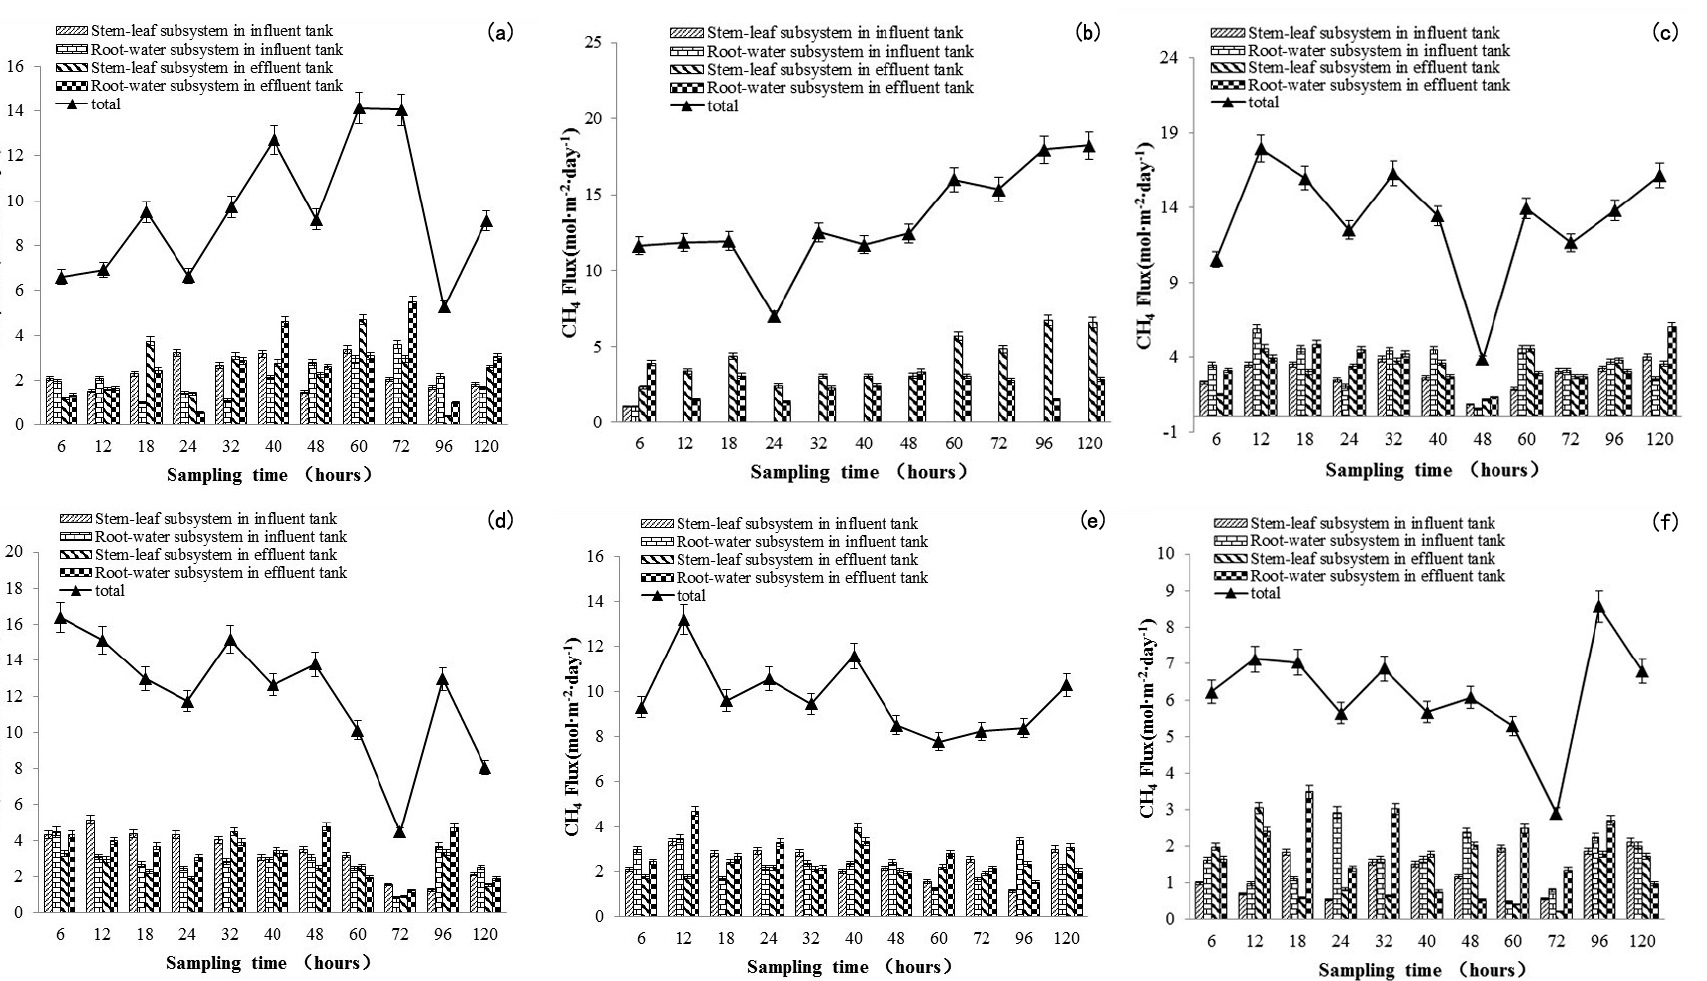
Figure 2. The methane emissions fluxes from the IVCW. ( a ) 0 mmol / L ethanol added; ( b ) 2 mmol / L ethanol added; ( c ) 4 mmol / L ethanol added; ( d ) 8 mmol / L ethanol added; ( e ) 16 mmol / L ethanol added; ( f ) 32mmol / L ethanol added.